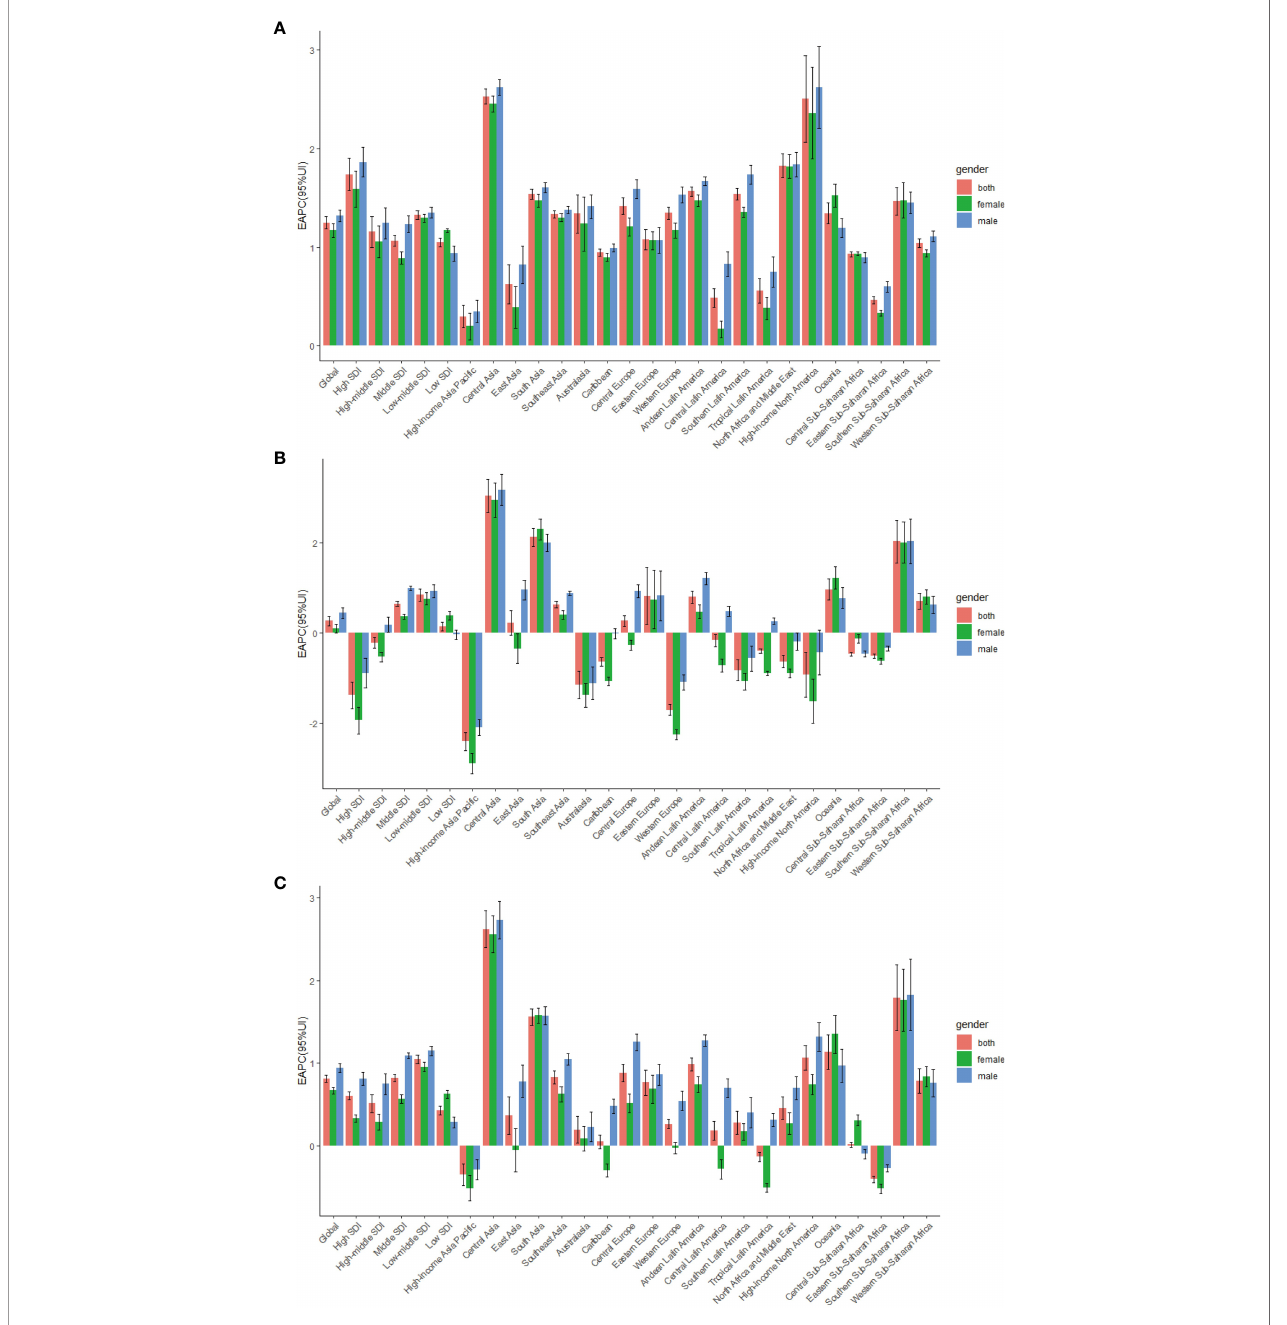
FIGURE 1 | The EAPC of T2DM age-standardized rates from 1990 to 2019, by sex and region. (A) The EAPC of ASIR. (B) The EAPC of ASDR. (C) The EAPC of age-standardized DALY rate; EAPC, estimated annual percentage change.ASIR, age standardized incidence rate; ASDR, age standardized death rate; DALY, disability adjusted